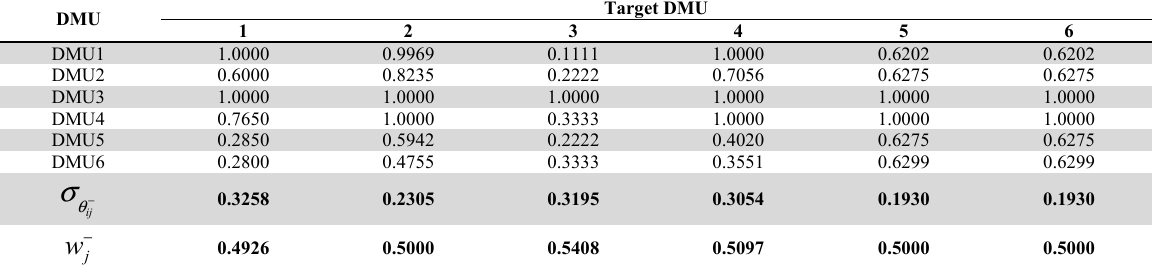
Anti-Ideal CEM of the methods of rice weevil disinfestations